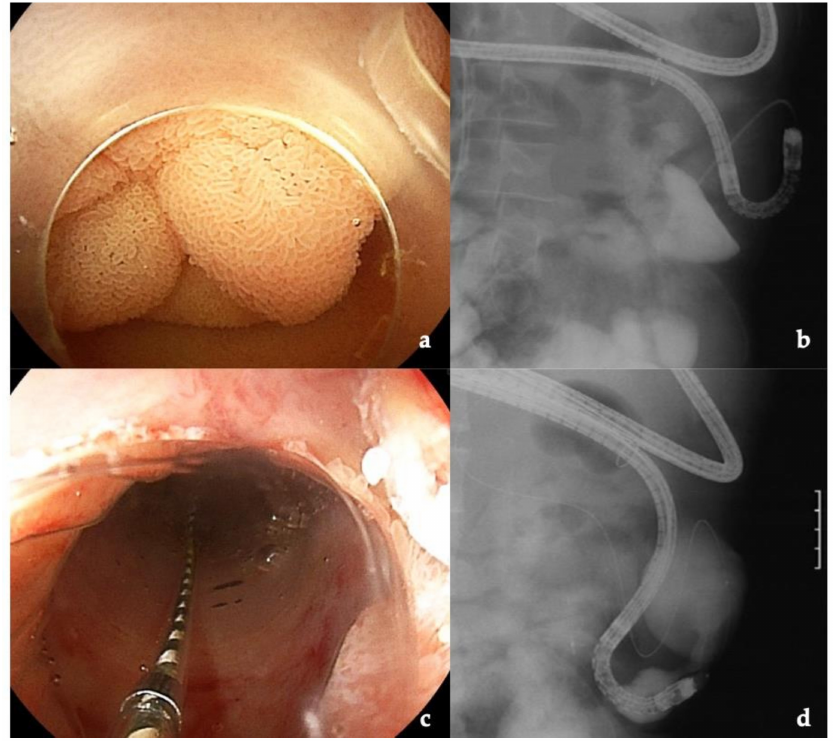
Figure 3. Intussusception antireflux valve in the afferent limb. The antireflux valve was created by invaginating the small intestine of the afferent limb to prevent cholangitis during childhood prior to living donor liver transplantation: ( a ) patient with intussusception antireflux valve; ( b ) antireflux valve with a stricture; ( c ) dilation with a balloon catheter; ( d ) the dilated antireflux